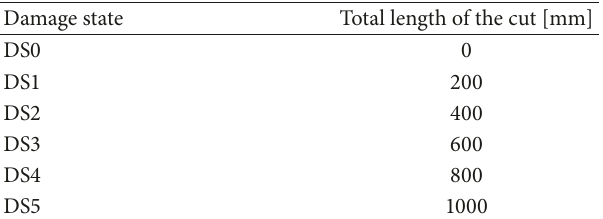
Table 1: Cut length at different damage states. Damage